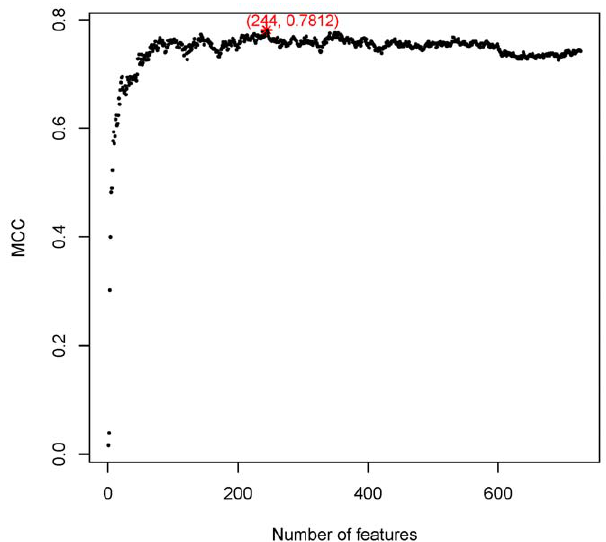
Figure 1. Distribution of MCC values against feature numbers. IFS predictive MCC values were plotted against feature numbers based on Table S1. The maximum MCC is 0.7812 using 244 features. These 244 features were considered as the optimal feature set of our classifier.